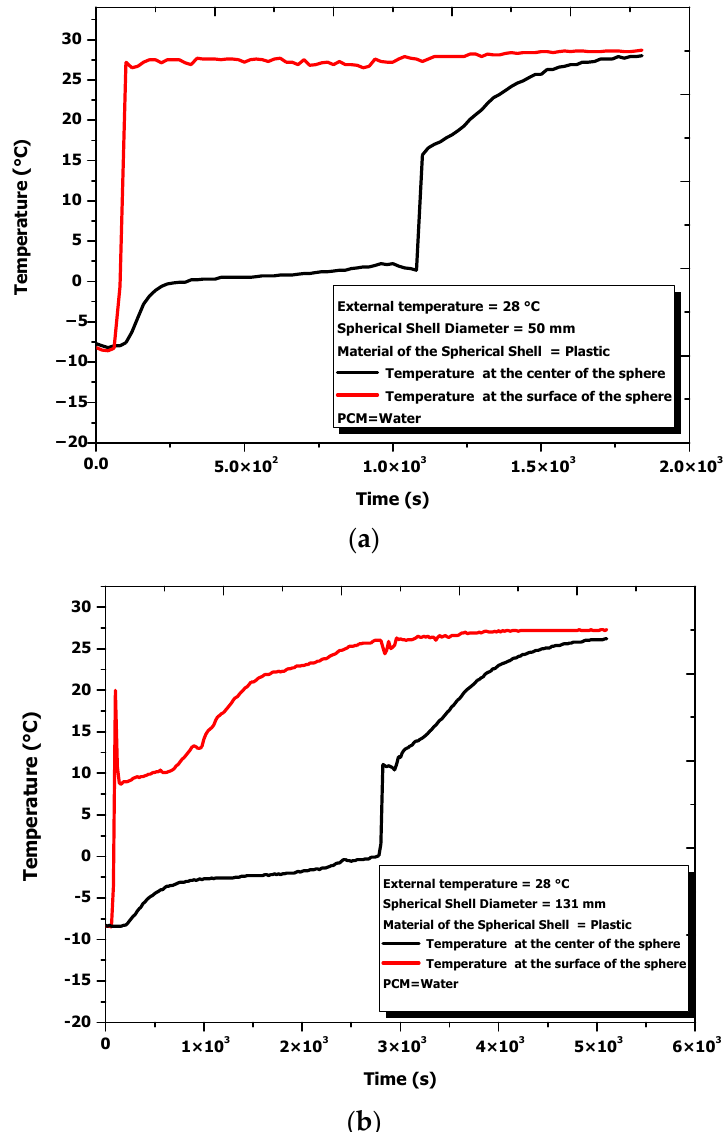
Figure 12. Temperature change in the center of the plastic spherical capsule during melt- ing of